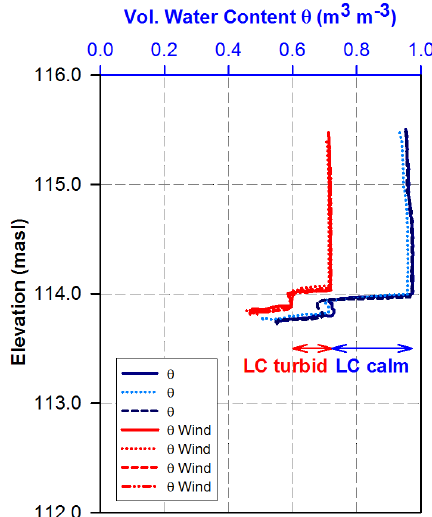
Figure 3. Volumetric water content θ Water and the lutocline LC are affected by the wind-induced upward diffusion: the lutocline LC, which indicates the water–mud interface, is more pronounced dur- ing calm conditions ( θ , LC calm, blue) than during windy condi- tions ( θ -Wind, LC turbid, red). The absolute height of the interface is not wind-affected. A good repetition of several consecutive mea- surements is shown